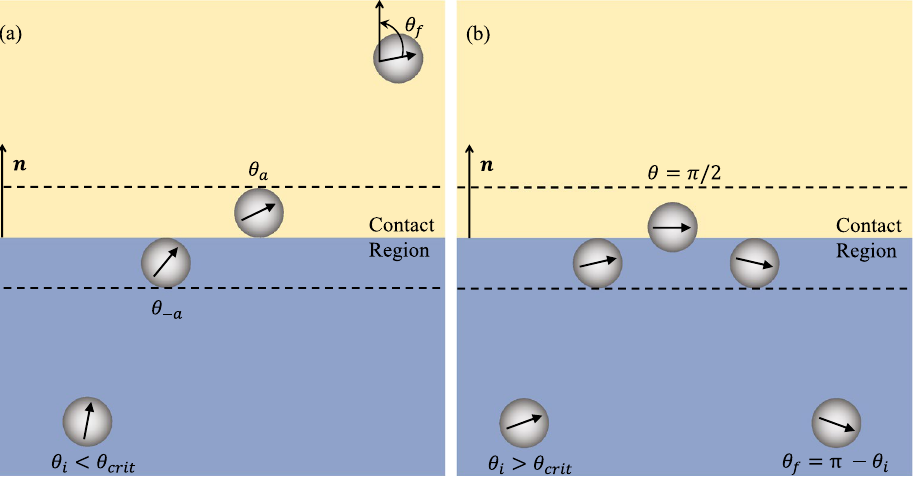
Figure 3. Schematic showing the reorientation of an active particle as it ( a ) crosses a viscosity interface or ( b ) gets reflected by the interface. This reorientation depends largely on the viscosity difference η 1 − η 0 and the particle is reflected only when going from low to high viscosity if its initial orientation is sufficiently shallow, θ i > θ crit